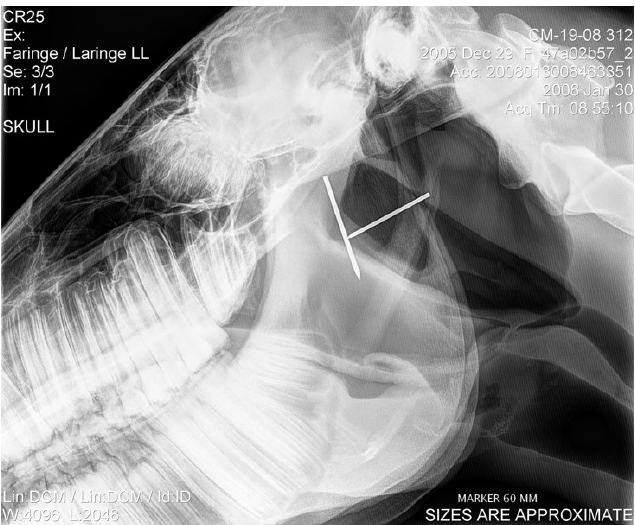
Figure 1. Example of how the radiographs were taken, with the markers of known length in place, to allow for epiglottis length measurements. allow for epiglottis length